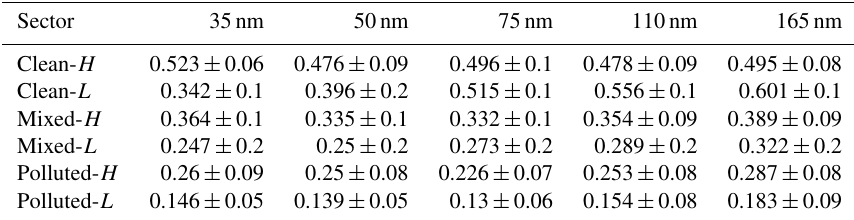
Table 5. The κ HTDMA in each type of air mass (arithmetic mean ± standard